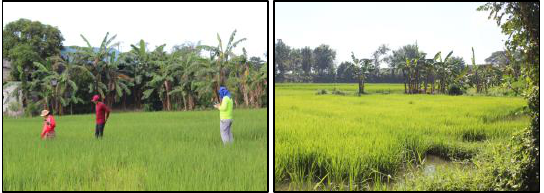
Figure 1. Delineation of Study Area in San Rafael, Bulacan